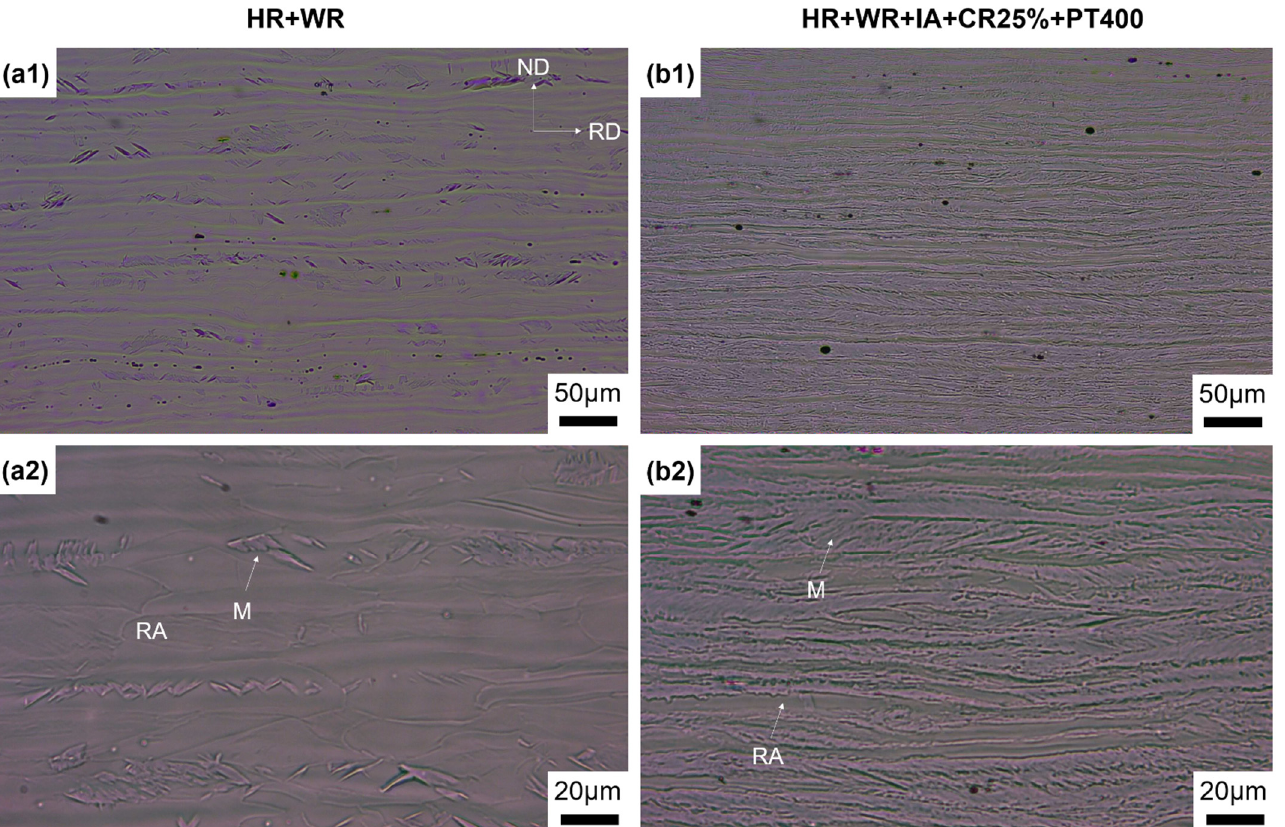
Figure 3. Optical micrographs showing the initial microstructures of the hot rolling (HR) + warm rolling (WR) sample ( a1 ), ( a2 ) and the HR + WR + intercritical annealing (IA) + cold rolling with 25% thickness reduction (CR25%) + partitioning at 400 °C (PT400) sample ( b1 ), ( b2 ). RD: rolling direction, ND: normal direction. M: martensite, RA: retained austenite.